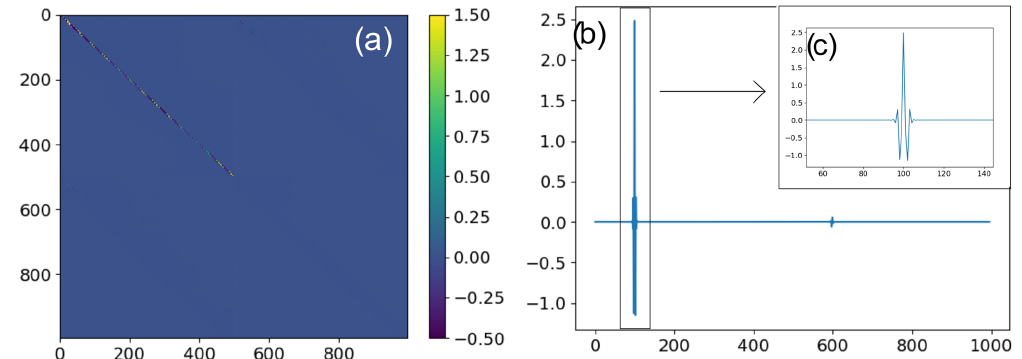
Figure D1. (a) Covariance matrix from response time correction of field experiment data. The [ a , a ] covariance is shown in the upper left quadrant, and the lower left and upper right quadrants with very faint but visible diagonals show the [ a , u ] and [ u , a ] covariance matrices (b) Row 100 of the covariance matrix and (c) a zoomed-in excerpt of row 100 of the covariance matrix ( approximate region indicated by the square in c)